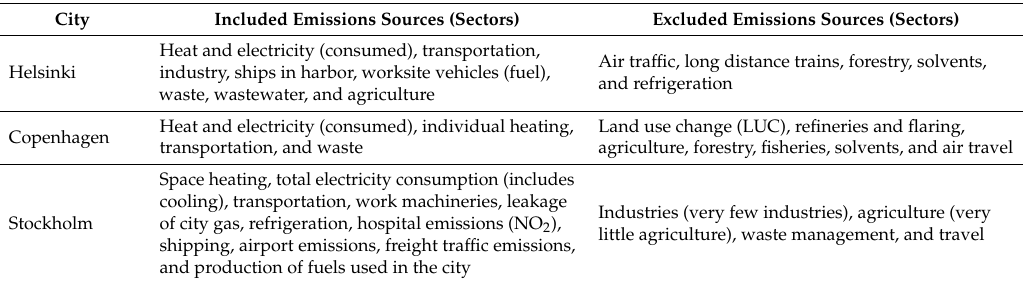
Table 1. Direct emissions sources included in and excluded from the current calculation methods by city